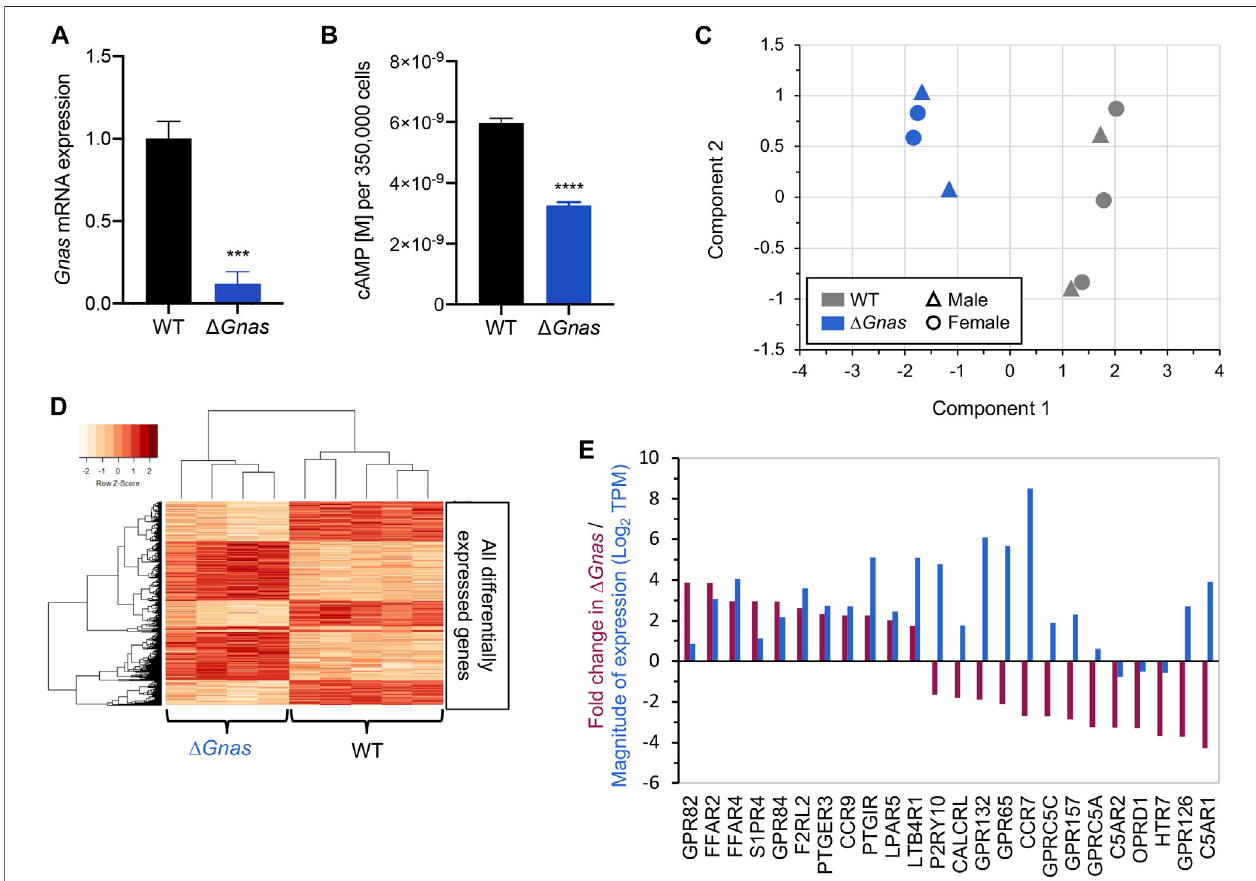
FIGURE 1 | Δ Gnas DCs have decreased cAMP levels and associated changes in gene expression. (A) Gnas gene expression in wild-type (WT) and Δ Gnas DCs; n =6, p < 0.001. (B) BasalcAMPlevelsinWTand Δ Gnas DCs; n =5-6, p < 0.0001. (C) WTand Δ Gnas DCRNA-SeqsamplesasvisualizedinaMultidimensionalScaling (MDS) plot wherein a data set is analyzed to cluster the results into principal components (component 1 and component 2). These components explain the greatest degree ofvariance acrossthesamplesanalyzed.ThedatashowthatWT and Δ Gnas DCsformtwoseparate clustersbasedongeneexpression. WT n =5, Δ Gnas n = 4. (D) Heatmap of differentially expressed genes. Each column lists the gene expression from a single biological replicate. WT n = 5, Δ Gnas n = 4. (E) Fold-change (Purple) and level of expression (Blue) of differentially expressed GPCRs in Δ Gnas DCs compared to WT cells. WT n = 5, Δ Gnas n = 4, FDR < 0.05.